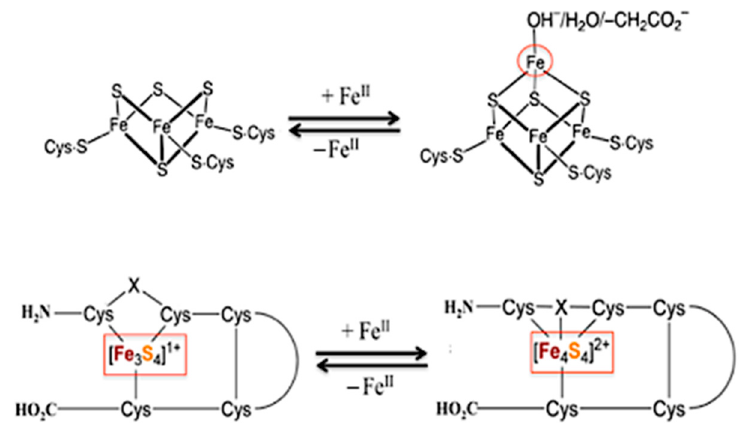
Figure 3. Inter-conversion between [3Fe-4S] and [4Fe-4S].